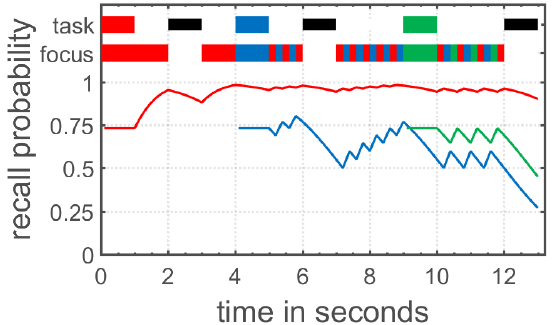
Figure 2. Visualization of the time-based resource sharing (TBRS) theory as implemented in the TBRS2 model by Gauvrit and Mathy [75]. At the top, the current task is displayed. A colored box represents a to- be-encoded memory item, a black box represents a distractor task, and a white box represents free time. Below, the focus of attention is shown. During free time, participants engage in refreshing of the already encoded memory item; during distractor tasks or encoding of other items, the already encoded memory items decay over